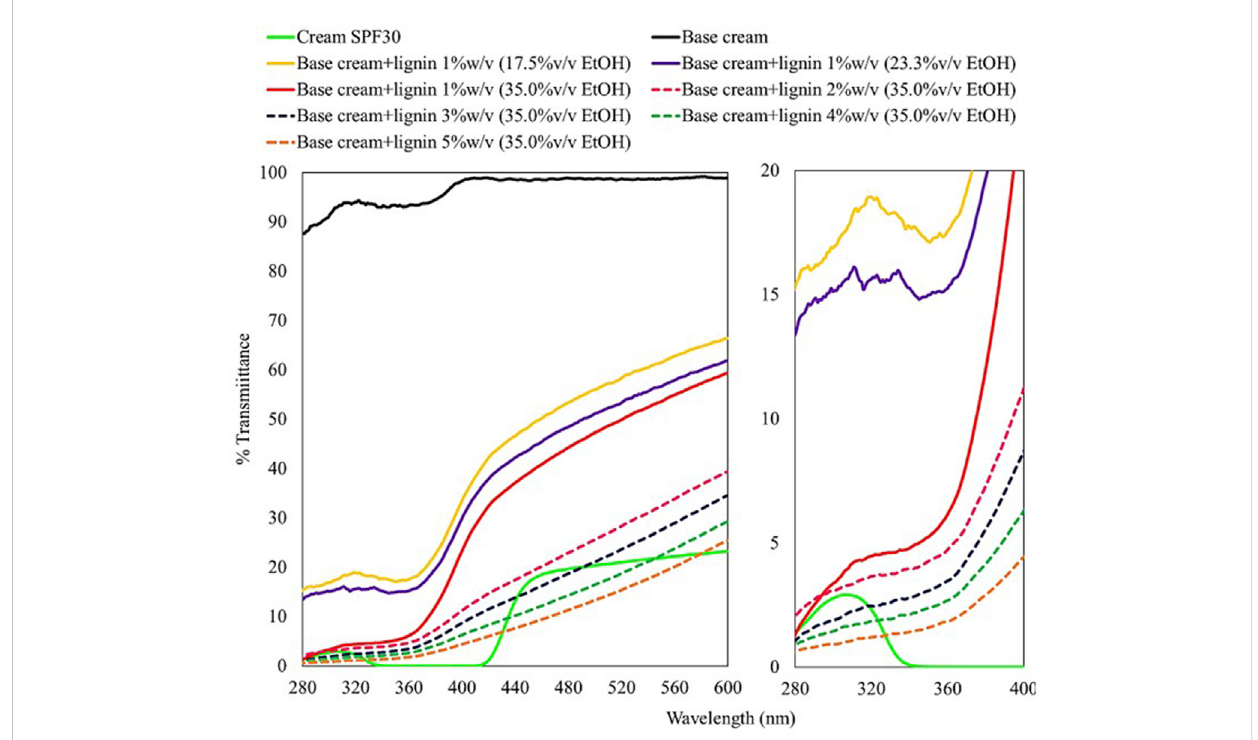
FIGURE 7 UV transmittance of cream SPF30 (commerical) and cream containing 1 – 5%w/v of thermal modi fi ed organosolv lignin (190 ° C) precipitated at various solvent dilutions.